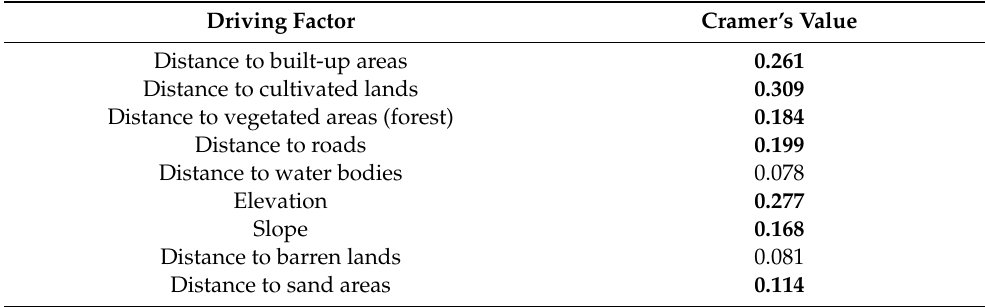
Table 1. Cramer’s coe ffi cient for potential factors of land-cover change for model calibration (Bold numbers show the drivers with strong associations used for the LULC